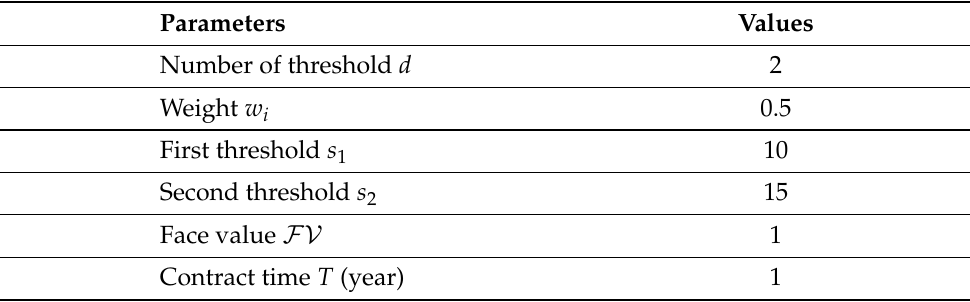
Table 5. Parameters used for cat bond pricing.